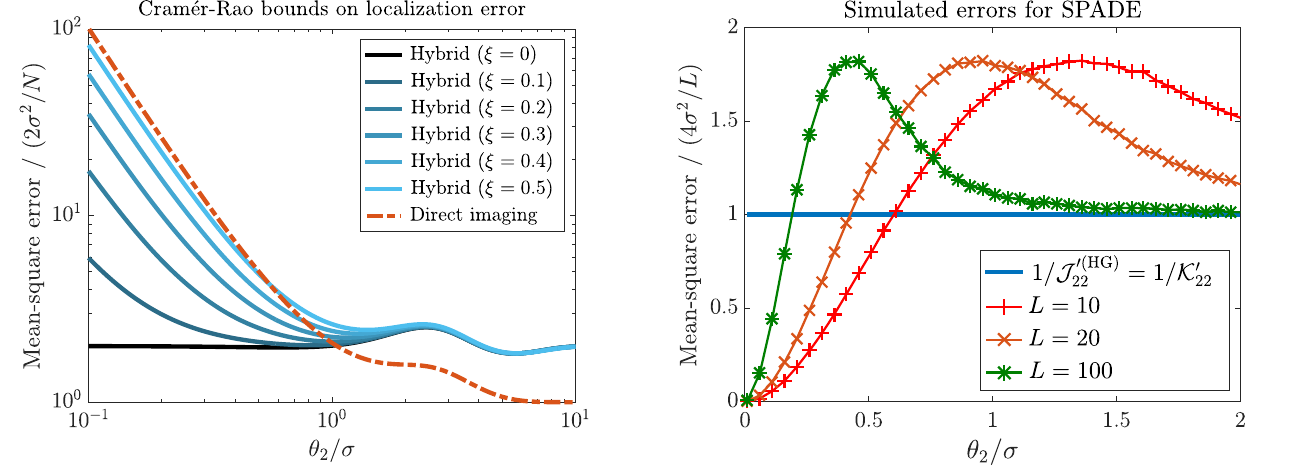
FIG. 14. Simulated mean-square errors for SPADE with maxi- mum-likelihood estimation, conditioned on L detected photons. Note that the vertical axis is normalized with respect to the Cramér-Rao bounds 4 σ 2 =L , so the plotted values are the actual errors magnified by L= ð 4 σ 2 Þ . Each error is computed by averaging 10 5 simulations, and the lines connecting the data points are guides for